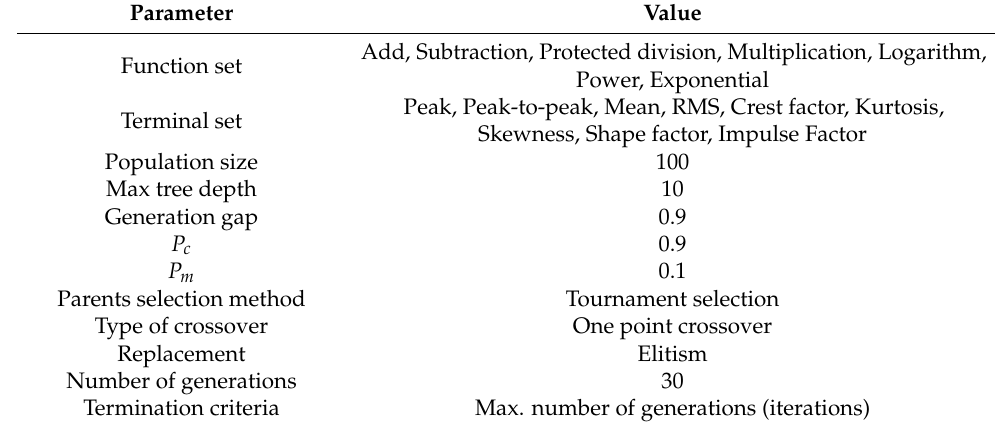
Table 6. GP parameters set.